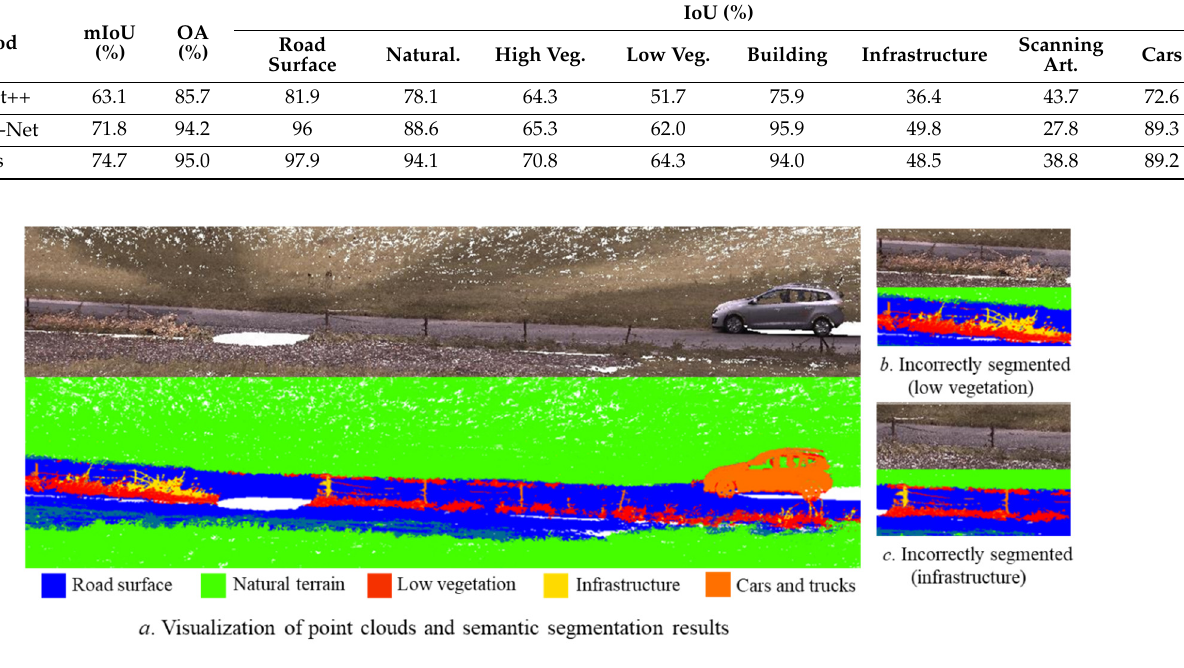
( b ) Figure 7. Extraction of the road boundary. ( a ) Intersection; ( b ) road. To accurately obtain the elevation of the entire intersection, the DEM is constructed by the interpolation method based on the uniformly distributed point set. The generated point set and DEM are shown in Figures 8 and 9.